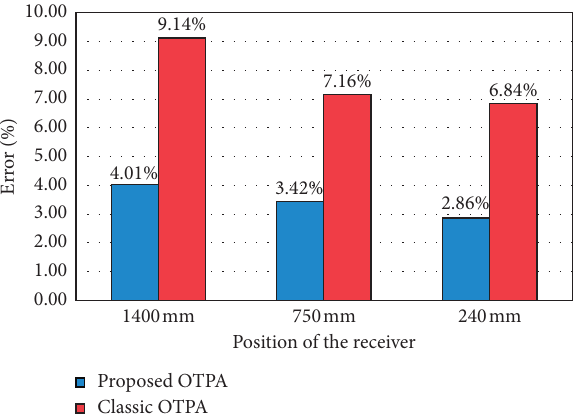
Figure 26: Errors of the proposed and classic OTPA for different